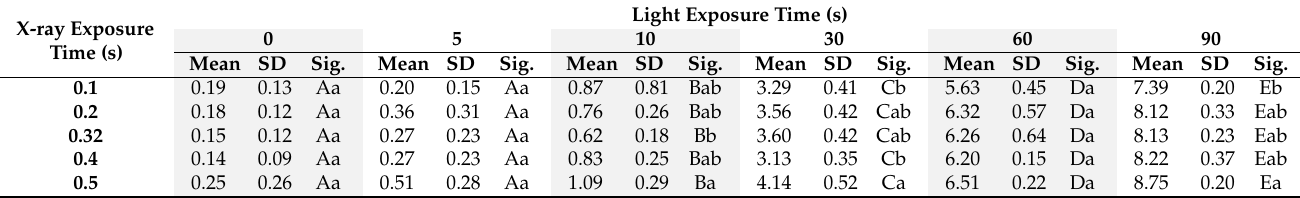
Table 3. Mean values, standard deviation (SD), and pairwise significance (Sig.) of contrast discrepancy as a function of light and X-ray exposure times for the VistaScan system.